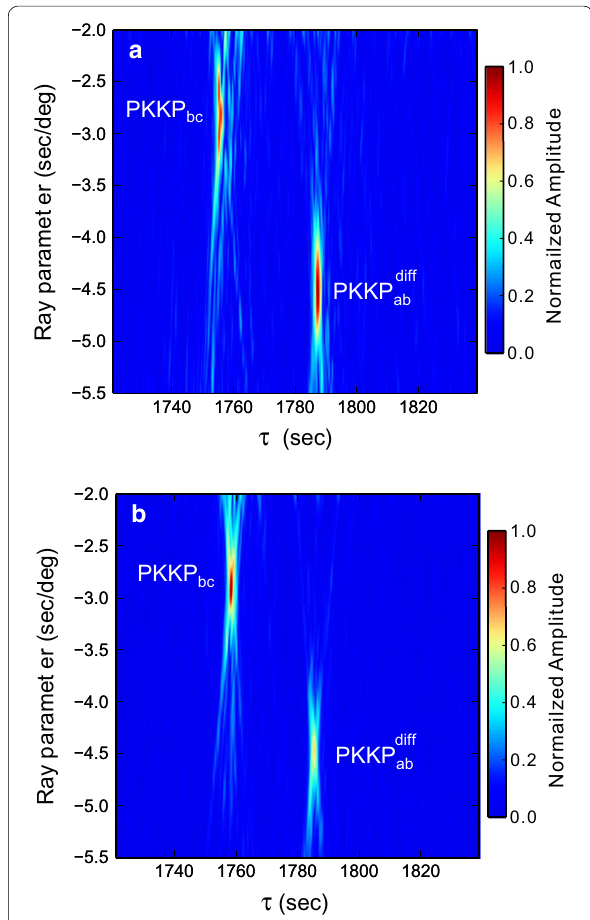
Fig. 5 Radon transform images of the two observations in Fig. 3. The ray parameters of PKKP bc and PKKP ab diffraction phases are clearly